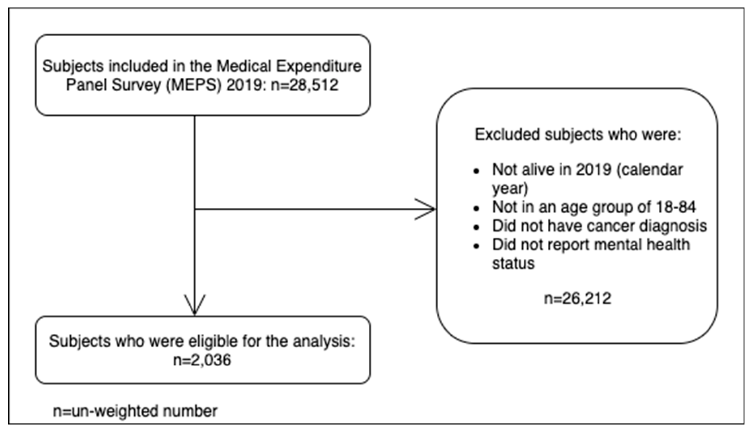
Figure 1. Subject selection flowchart.